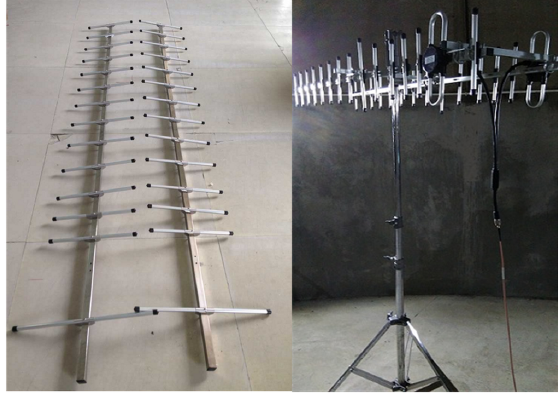
Figure 2. Photographs of the reference antenna.